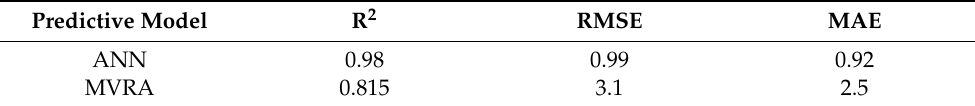
Table 6. Performance indices of ANN and MVRA models